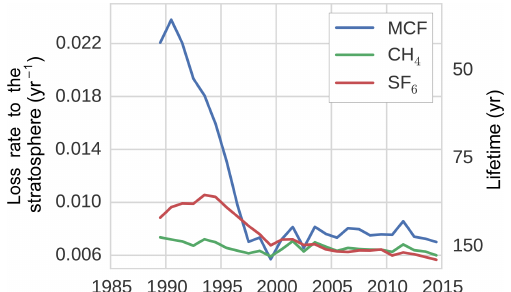
Figure 5. The tropospheric loss rate to the stratosphere, as derived from the TM5 simulations (see Sect.